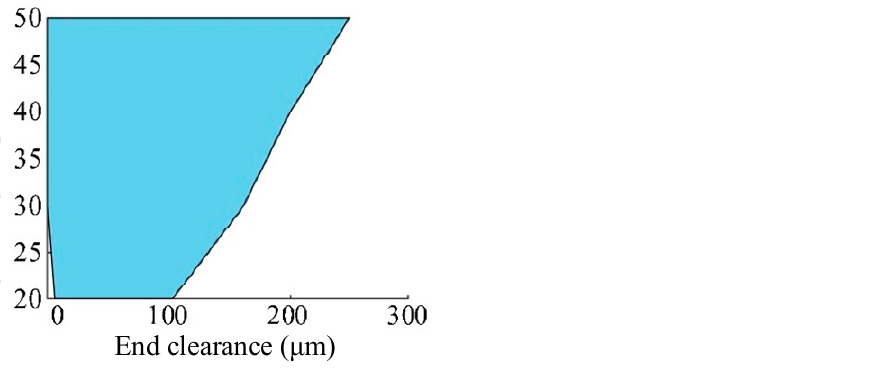
Figure 11. The ranges of the tightening torque and the end clearance when the contact state of the spindle–GWF interface is two-sided contact after assembly.